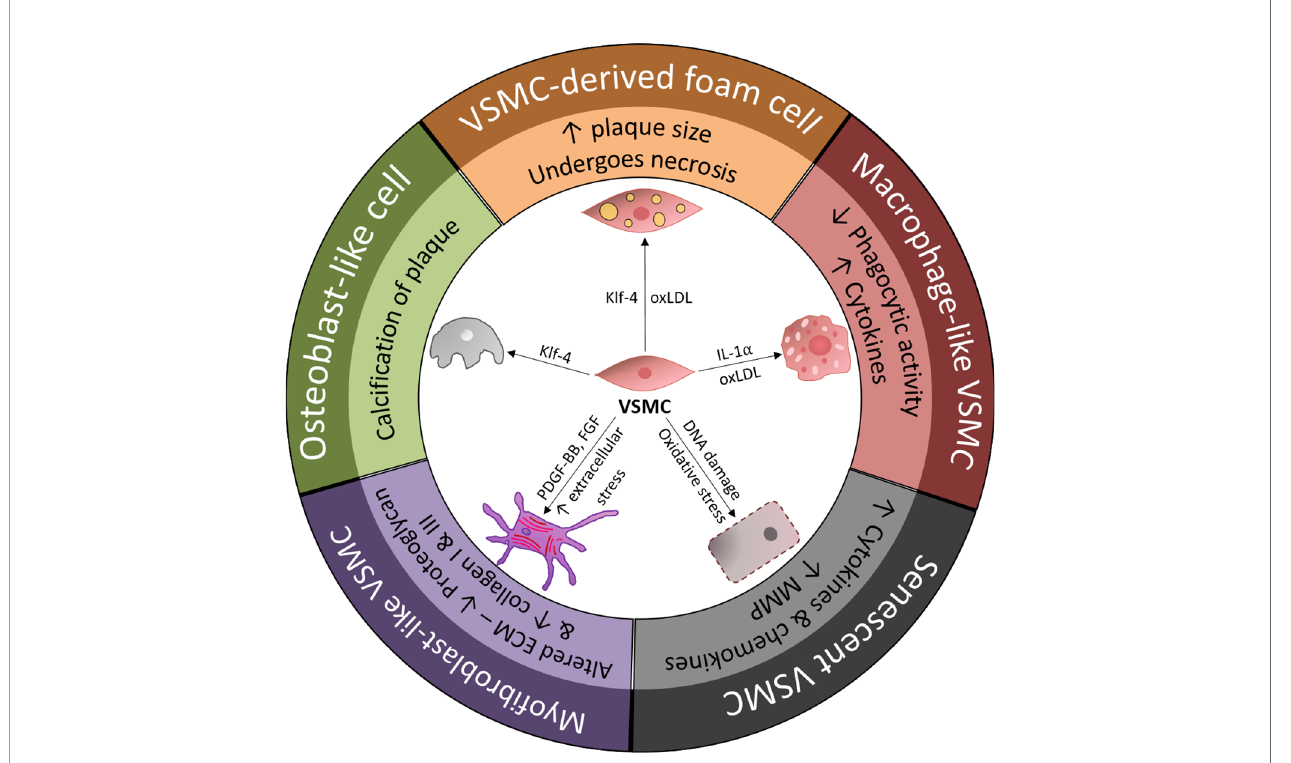
FIGURE 1 | Overview of vascular smooth muscle cell (VSMC) phenotypic transition within the arterial wall and the main drivers of VSMC differentiation. ECM, extracellular matrix; FGF, fi broblast-growth factor; KLF-4, Kruppel-like factor 4; MMP, matrix metalloproteinase; oxLDL, oxidized low-density lipoprotein; PDGF-BB, platelet-derived growth factor-BB; VSMC, vascular smooth muscle